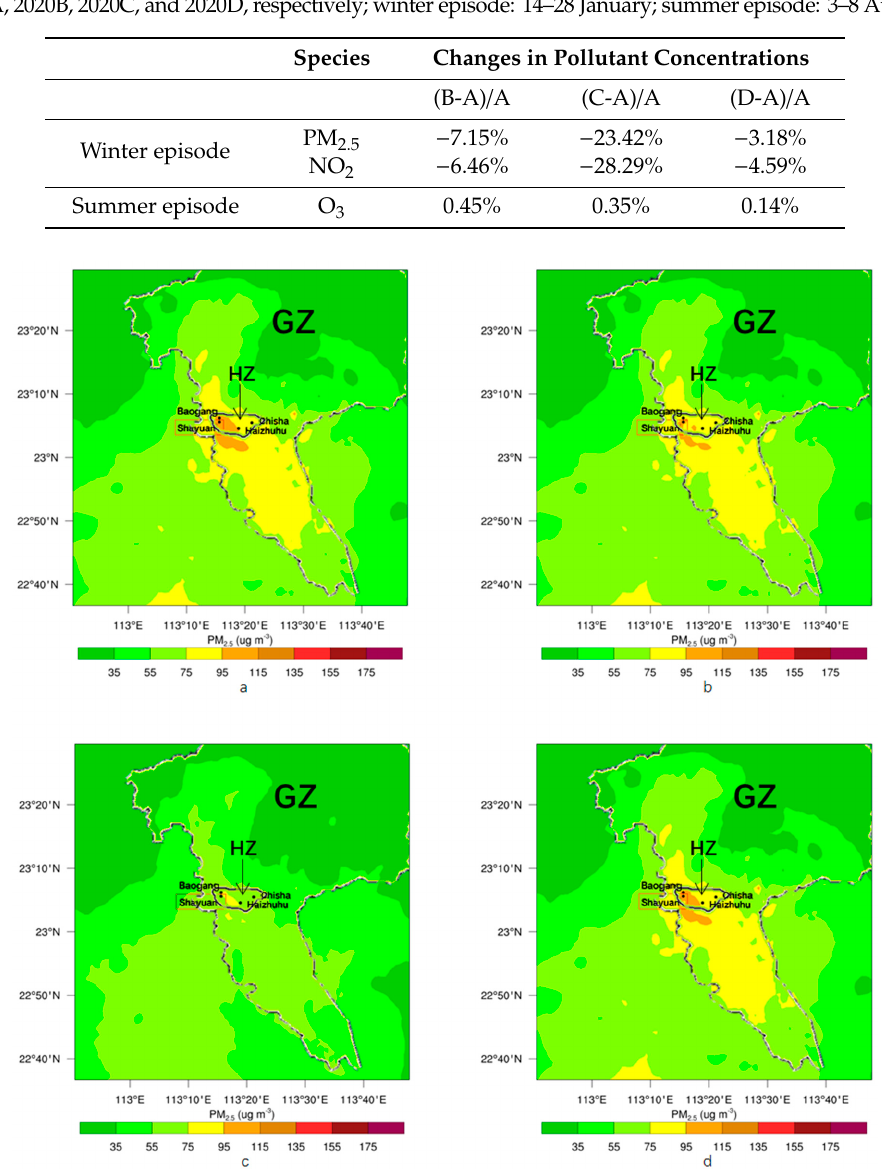
Figure 7. Maps of the simulated mean PM 2.5 concentration distribution during the period 0000 BJT,